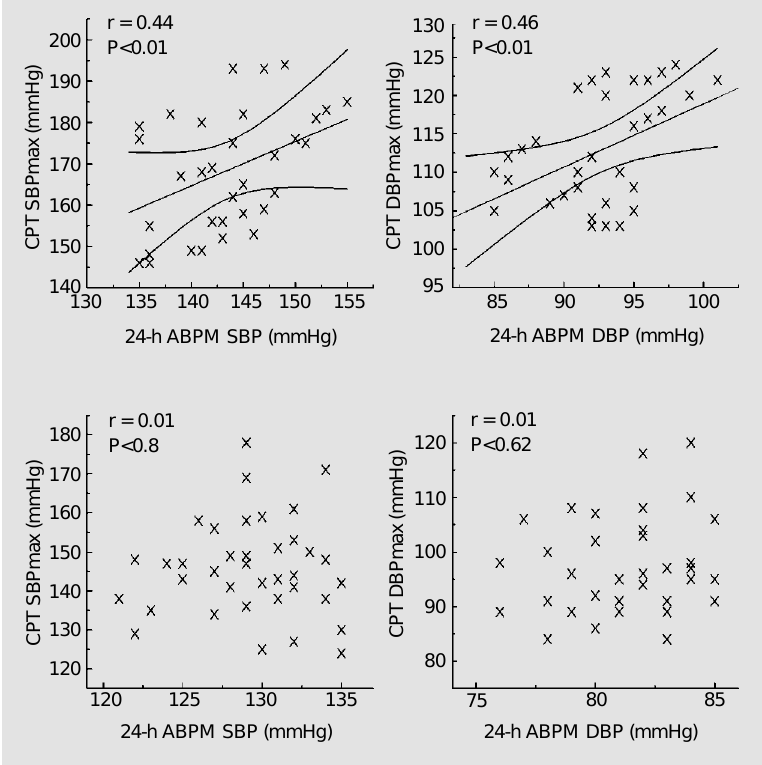
3. Simple correlation coefficient (r) between 24-h ambulatory blood pressure